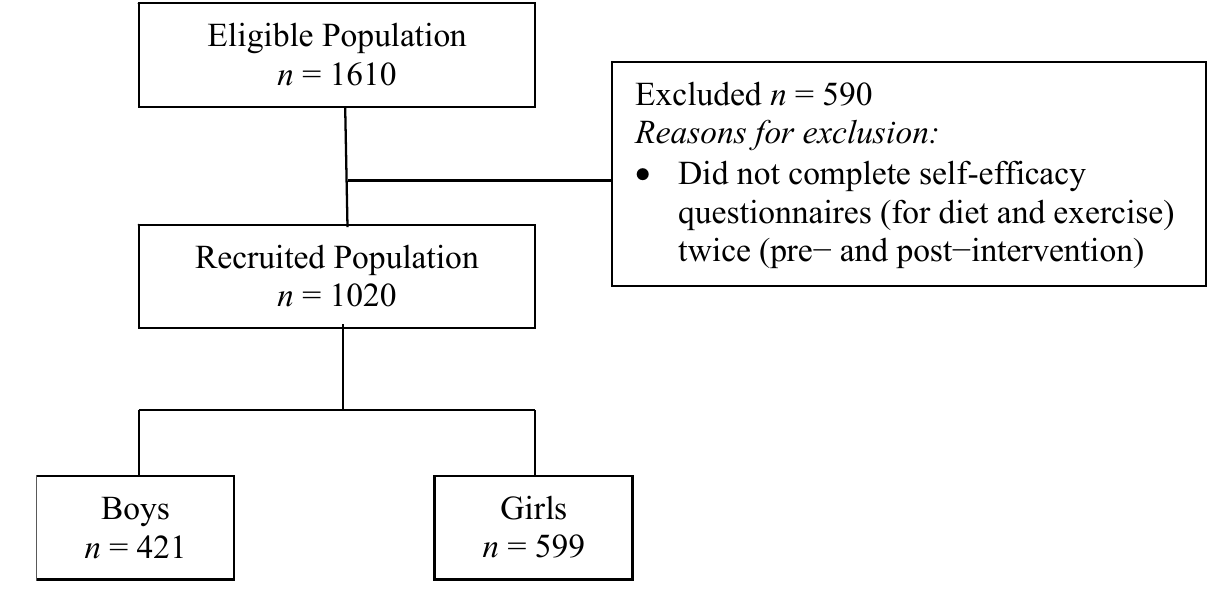
Figure 1. Flowchart of study participants. Table 1. Adolescents’ demographic and anthropometric characteristics pre- and post-intervention (N = 1020) and according to weight